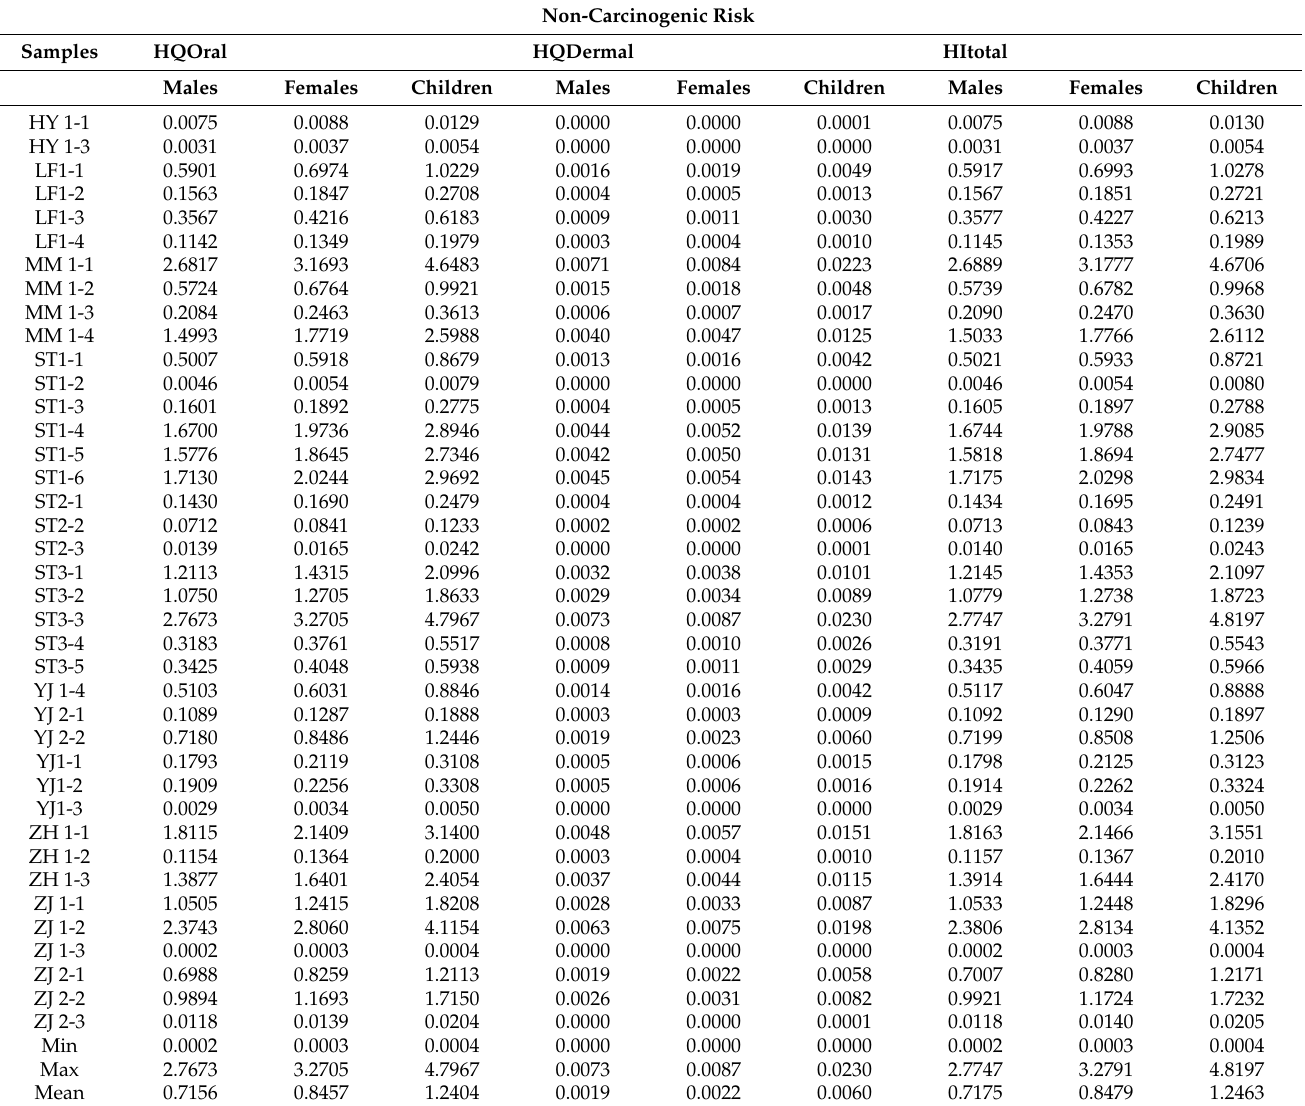
Table A1. Nitrate results of non-carcinogenic risk through drinking water intake and dermal